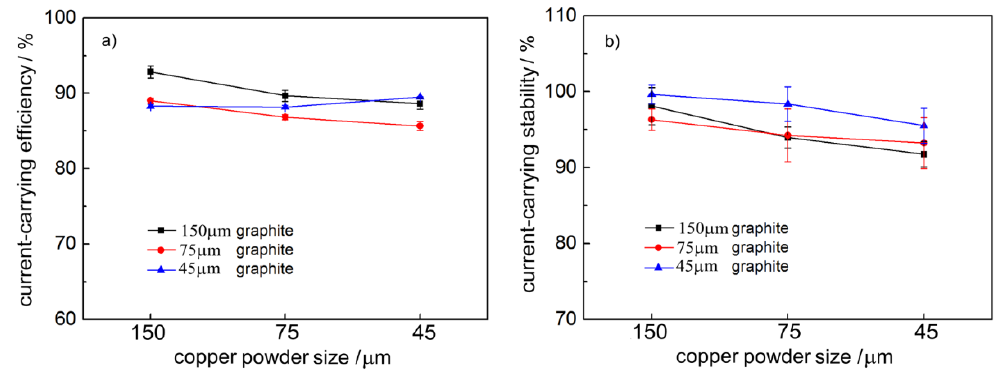
Figure 5. Current-carrying properties of the copper-graphite composites: ( a ) current-carrying efficiency, ( b ) current-carrying stability.